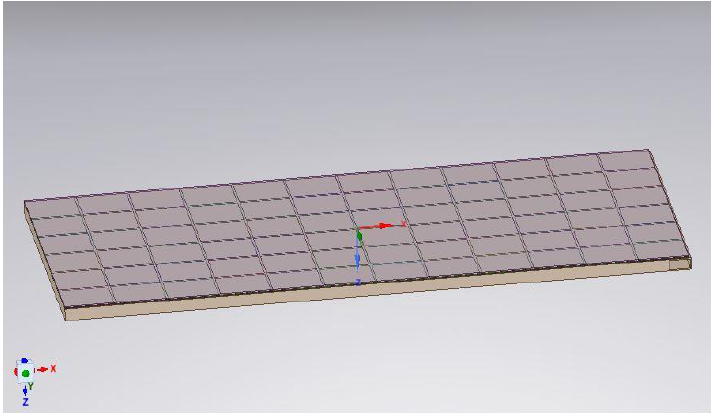
Figure 13. CAD model of the hybrid solar panel.